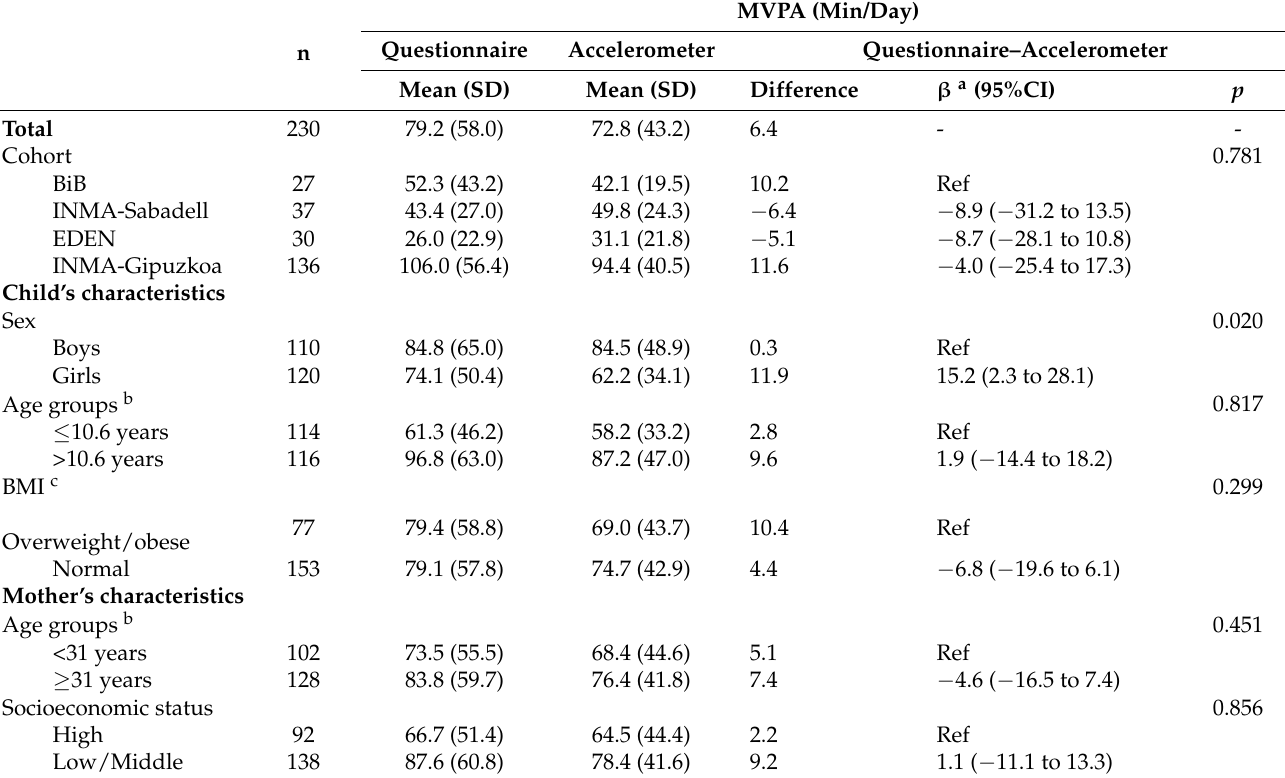
Table 2. Linear regression of the difference between questionnaire and accelerometer MVPA time adjusted for child’s and mother’s